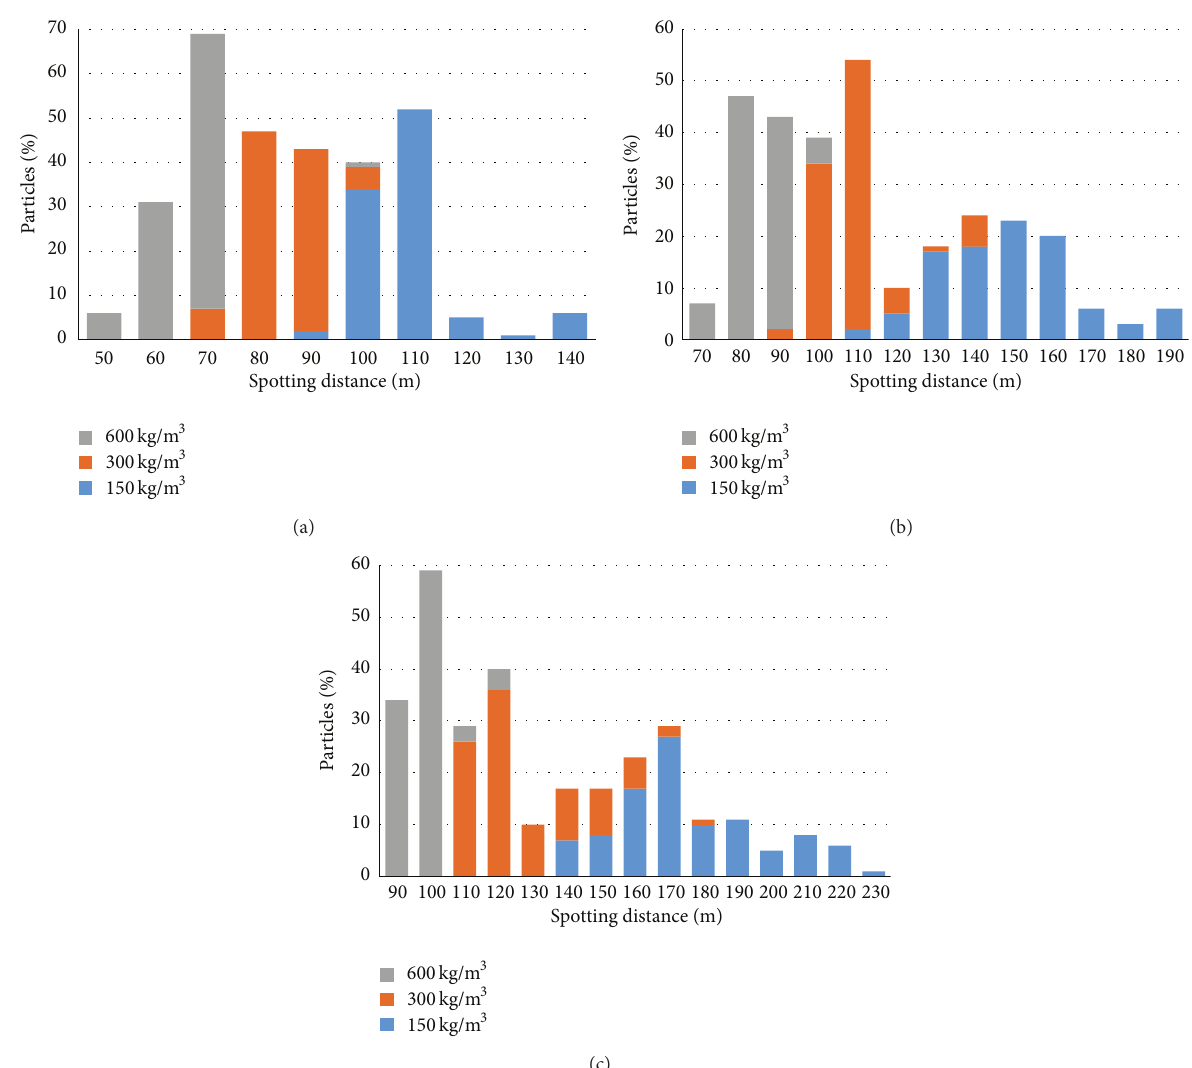
Figure 5: Spotting distances of the spherical particles for three different densities, 150, 300, and 600 kg/m 3 , and three different drag coefficients, (a) Cd = 0.4; (b) Cd = 0.8; and (c) Cd =